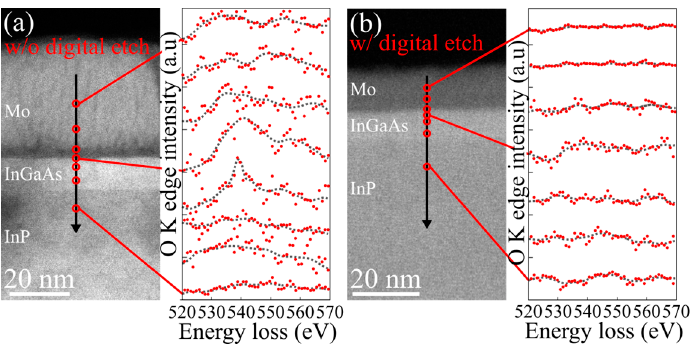
Figure 4. STEM-HAADF image of the metal/semiconductor interface of sample ( a ) without the digital etch treatment and ( b ) with the digital etch treatment. The arrow represents the localization of the EELS spectra recorded point-by-point.